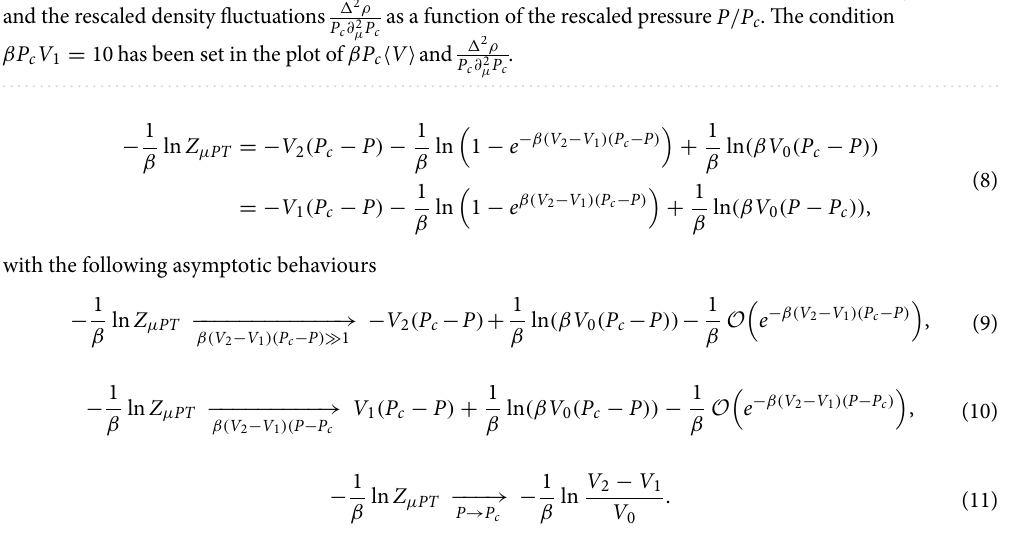
P / P c . The condition